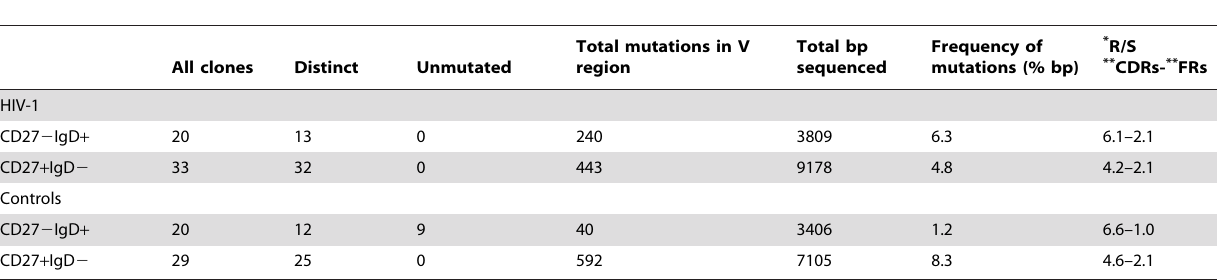
Table 1. Mutations in VH3-C c transcripts from sorted CD27 2 IgD + and CD27 + IgD 2 B cells from HIV-1 infected patients and healthy controls.